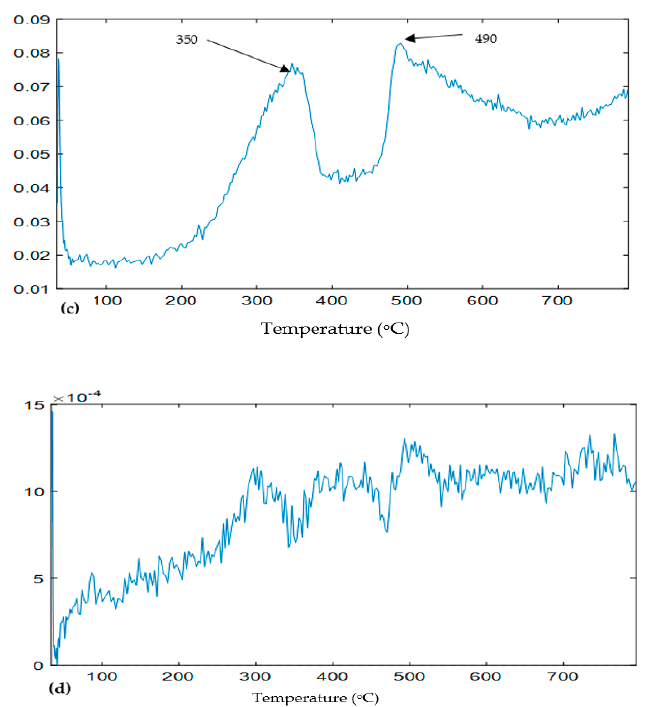
Figure 7. Loadings of the PARAFAC model. ( a ) Mode 2 loadings of component 2 (TGIS), ( b ) mode 2 loadings of component 2 (TGO), ( c ) mode 3 loadings of component 2 (TGIS), and ( d ) mode 3 loadings of component 2 (TGO). X-values are wavenumber cm − 1 in ( a , b ) and temperature °C in ( c , d ). Y-values are scaled values of the components. The red circle in ( b ) shows a peak not seen in ( a ).